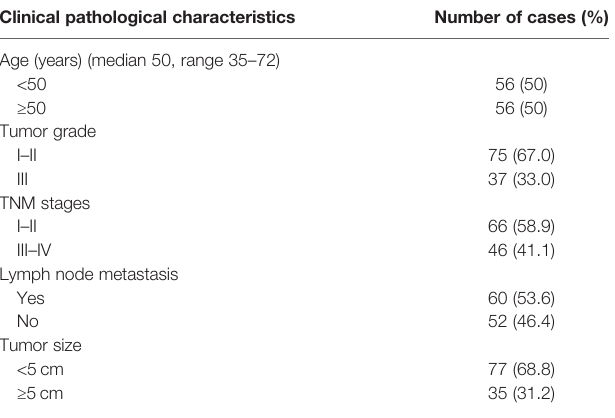
TABLE 4 | Clinical pathological characteristics of breast cancer patients (n =